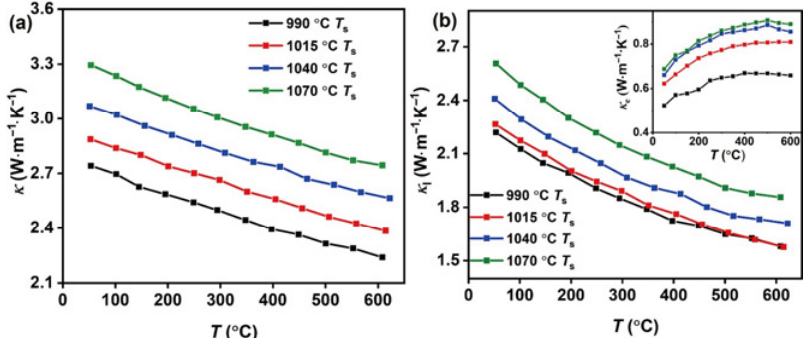
Fig. 6 Temperature-dependent thermal properties for different T s (990, 1015, 1040, and 1070 ℃ ) of SPS: (a)  and (b) (the inset is the corresponding